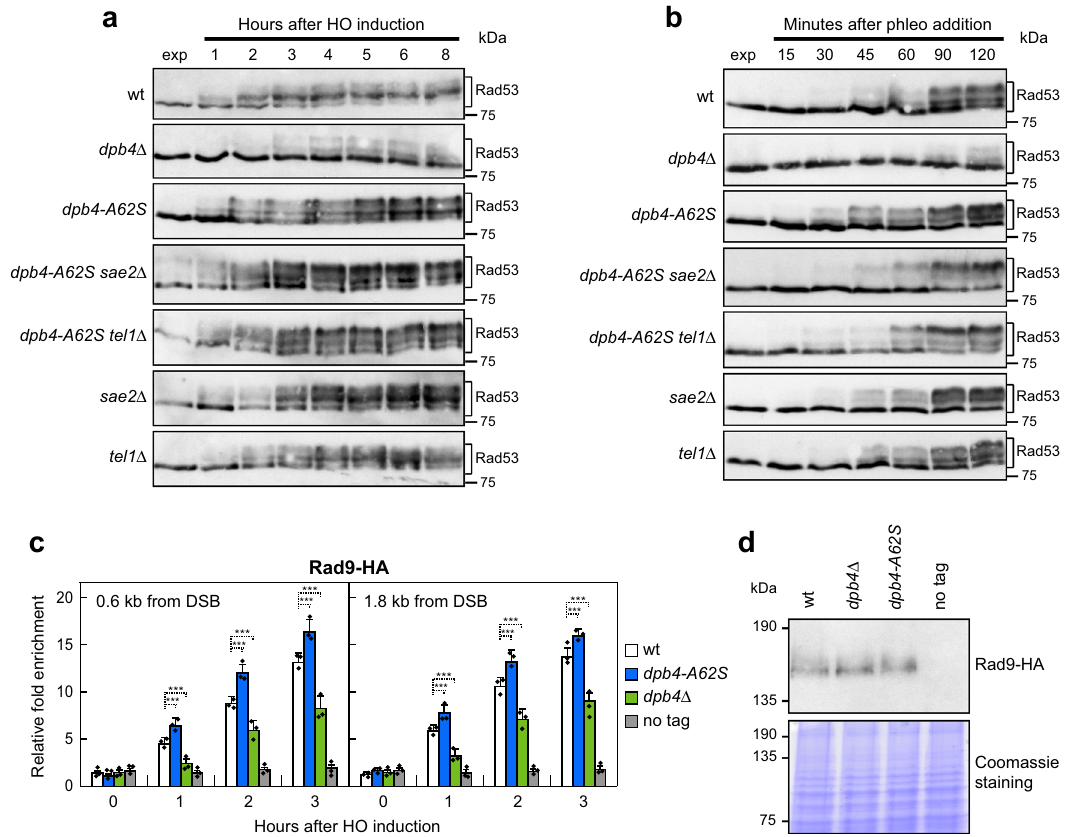
Fig. 3 Opposite effect of dpb4 Δ and dpb4-A62S on checkpoint activation and Rad9 association at DSBs. a YEPR exponentially growing cell cultures of JKM139 derivative strains were transferred to YEPRG at time zero. Western blot analysis with anti-Rad53 antibodies of protein extracts from samples taken at the indicated times after HO induction. The experiment was performed independently two times with similar results. b Phleomycin (10 μ g/mL) was added to exponentially growing cells followed by western blot analysis with anti-Rad53 antibodies. The experiment was performed independently four times with similar results. c Exponentially growing YEPR cell cultures of JKM139 derivative strains were transferred to YEPRG to induce HO expression. Relative fold enrichment of Rad9-HA at the HO-induced DSB was evaluated after ChIP with anti-HA antibody and qPCR. The mean values of three independent experiments are represented with error bars denoting s.d. *** p < 0.005 (unpaired two-tailed Student ’ s t -test). d Western blot with anti-HA antibodies of protein extracts from exponentially growing cells. The experiment was performed independently three times with similar